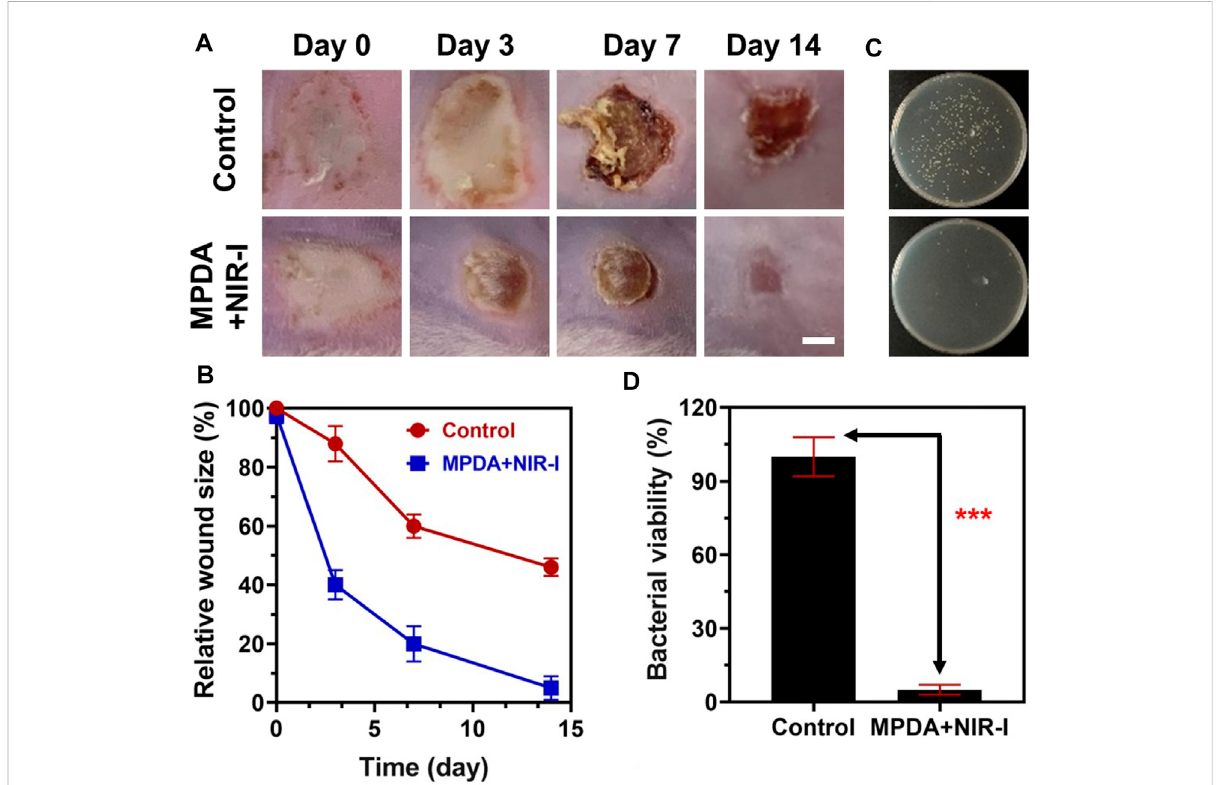
Anti-infective therapy of MPDA in vivo with subcutaneous abscess model. (A) Representative photographs of the mice with subcutaneous abscesses on the 0, 3 rd , 7 th , and 14th day post-treatment. Scale bar, 2 mm. (B) Corresponding quantitative analysis of the infected area with various therapies. (C) Representative photographs of the bacterial colony from bacteria-infected tissues with various therapies on the 14th day. (D) Corresponding quantitative analysis of the number of bacterial colonies from bacteria-infected tissues with various therapies on the 14th day. Data are presented as mean ± SD ( n = 3), *** p <